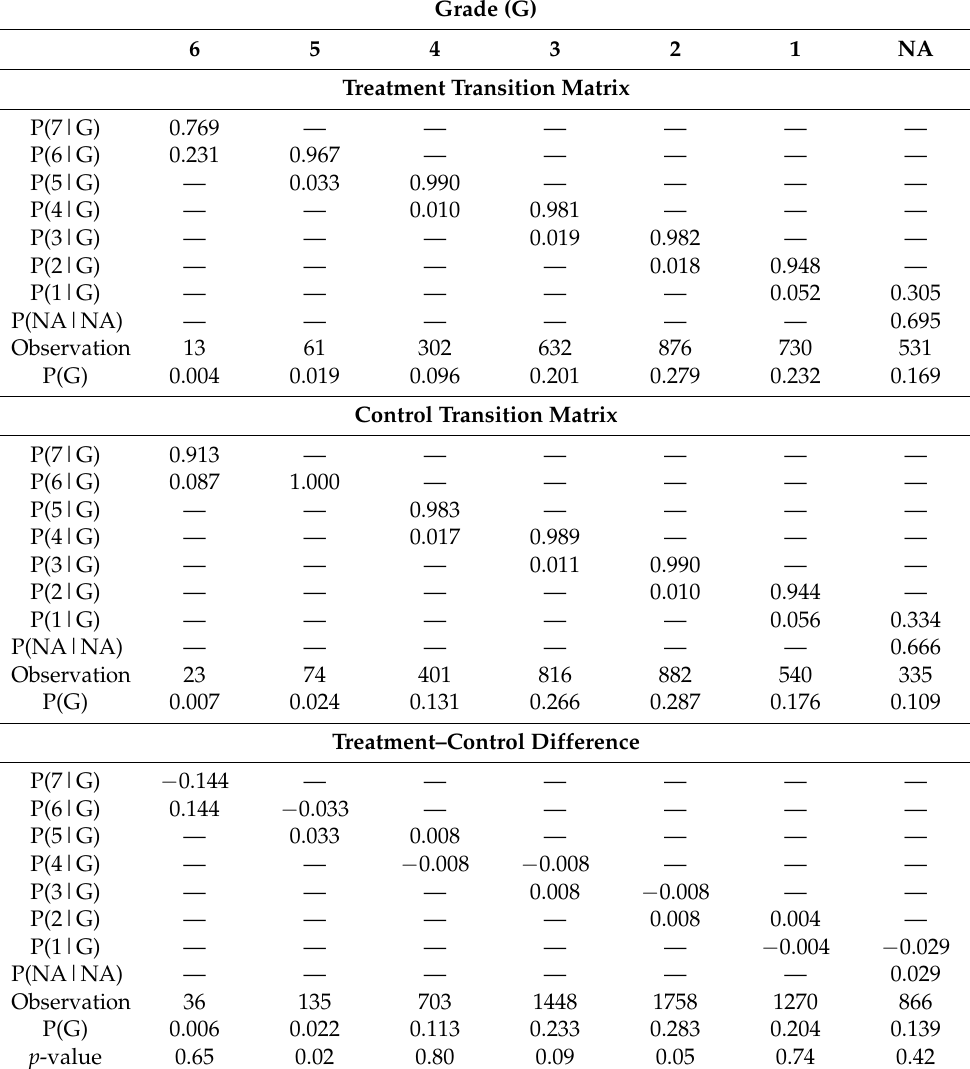
Table A3. Transition matrices (ages 9–10).